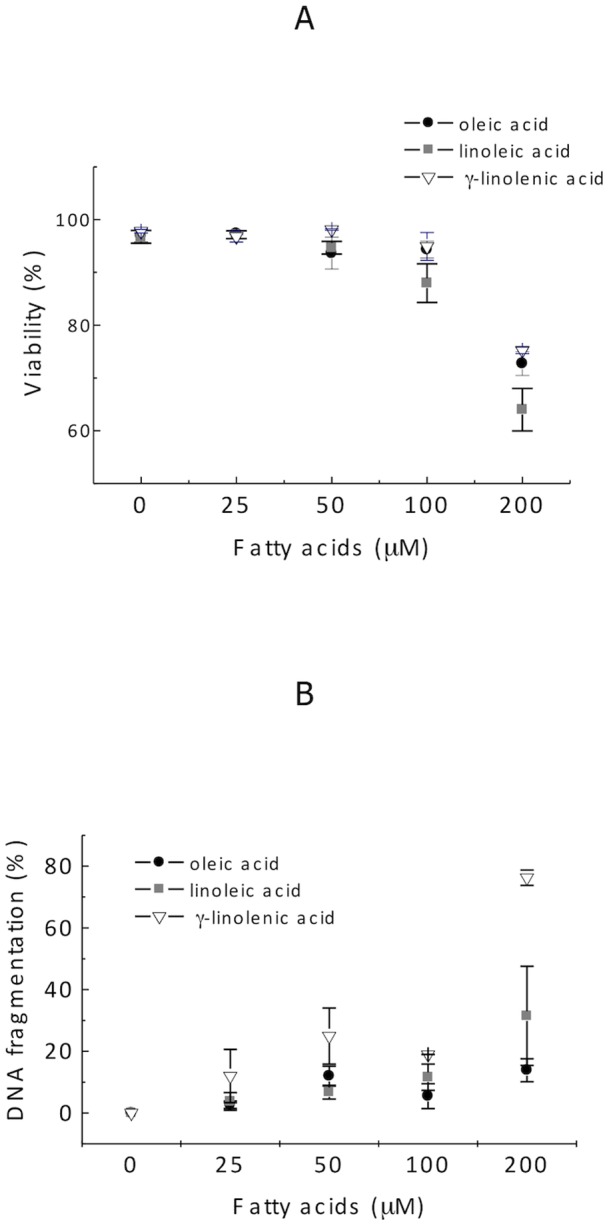
Analysis of membrane integrity and DNA fragmentation.Confluent 3T3 Swiss fibroblasts were treated with vehicle control (0) or oleic, linoleic or γ-linolenic acid (10, 20, 50, 100 or 200 μM). The results are presented as the mean ± standard error of at least three experiments that were performed in duplicate.